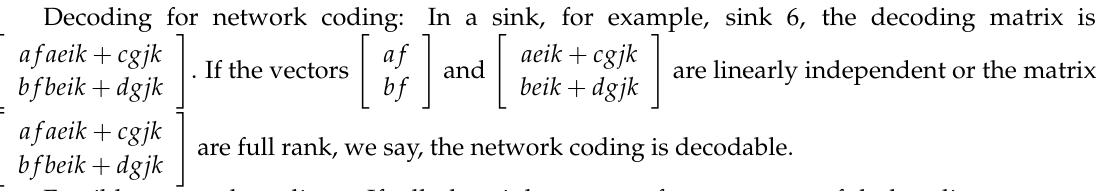
Figure 1. Network coding on butter-fly network. We illustrate the concept of “propagated error” with red and blue symbol “ × ”. The red part shows the concepts about block transmission in network coding.